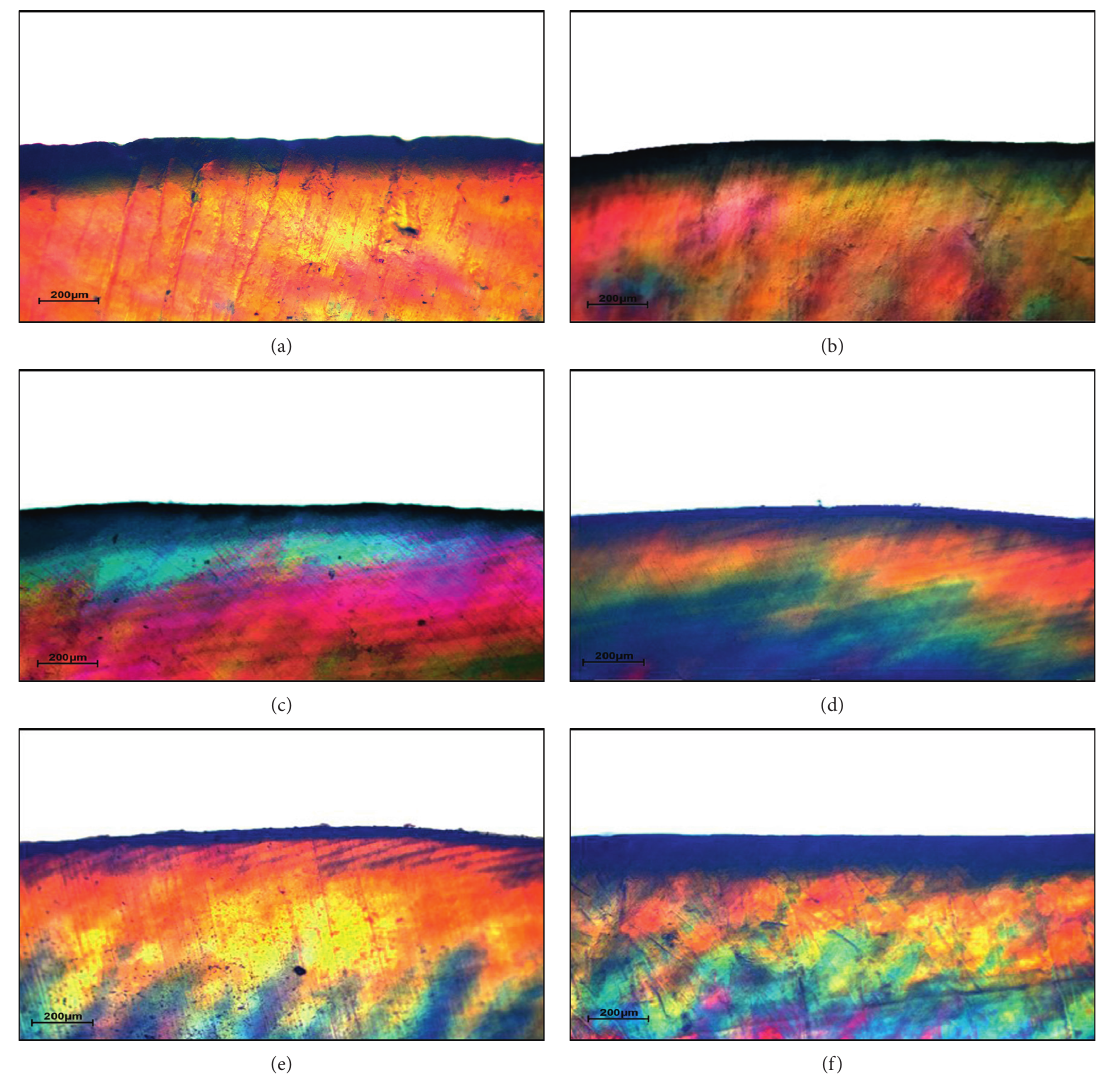
Figure 3: Polarized-light photomicrograph (PLM) of enamel ( × 10) after demineralization (a), followed by remineralization with fluoride varnish (b) nano-hydroxyapatite toothpaste (c), 20% nano-hydroxyapatite gel (d), 30% nano-hydroxyapatite gel (e) compared to no treatment group